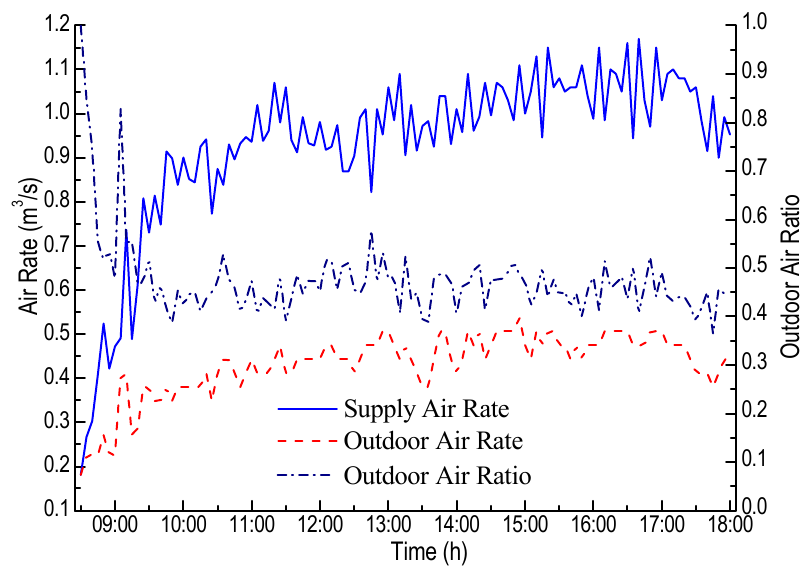
Figure 13. Supply air rate of six zones under Scenario 3.